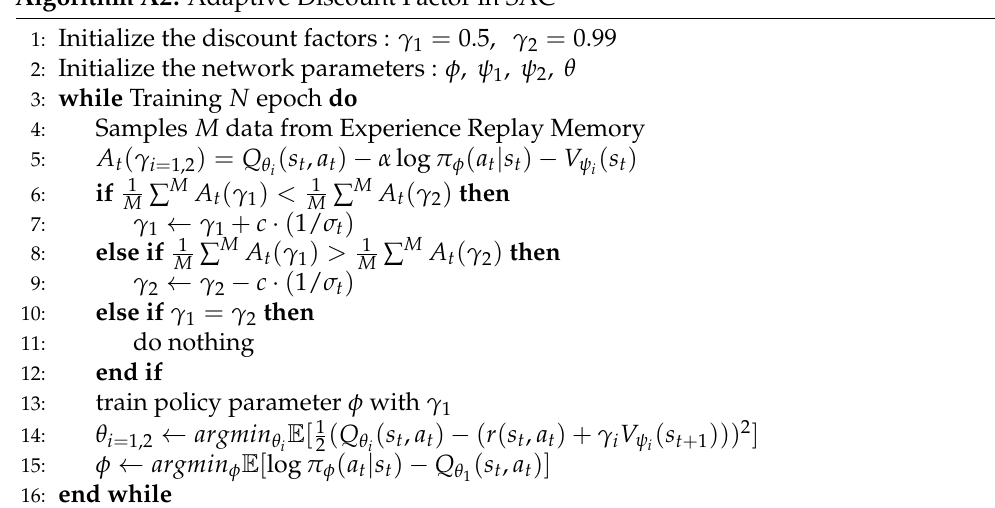
Algorithm A2: Adaptive Discount Factor in